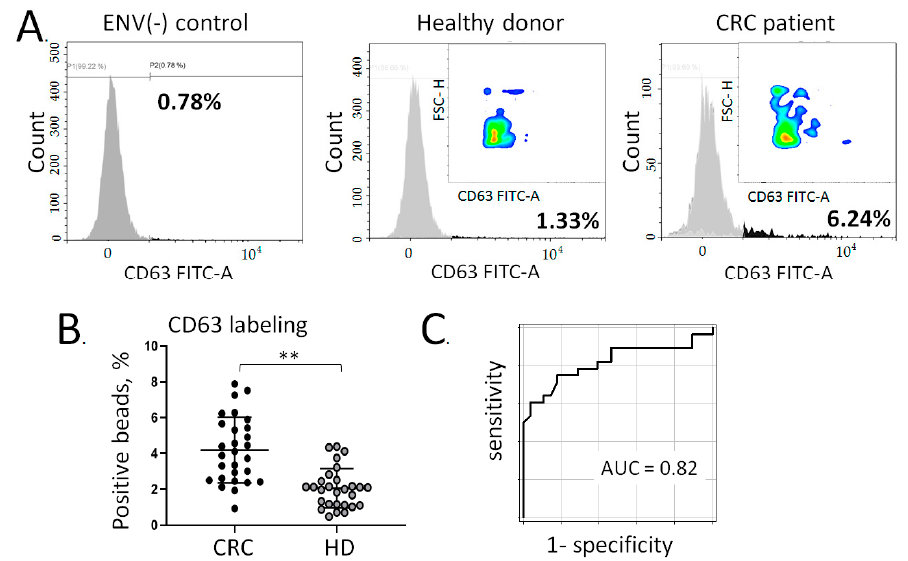
Figure 4. Multiplexed isolation and quantification of colon-derived ENVs in the plasma of CRC (II-IIIa) patients and healthy donors. The total population of plasma ENVs was isolated with PTPS, and the fraction of colon-derived ENVs was isolated using immunobeads decorated with antibodies against CLRN3, GCNT3, GPA33, PIGY, and REG4. ENVs captured by the immune beads were labelled with FITC-conjugated antibodies against the exosomal marker CD63 and quantified by flow cytometry. ( A ) Representative examples of the histograms (negative control, healthy donor, and patients) after labelling with anti-CD63-FITC. Colored inserts present pseudo-color/smooth plots of positive events. ( B ) Direct comparison of the CRC (II-IIIa) patients (n = 28) vs. the healthy donors (n = 30). The statistical significance was estimated using nonparametric Mann-Whitney test (** p < 0.005). ( C ) Evaluation of the diagnostic potency of the method by receiver operating characteristic (ROC) analysis in the same groups of